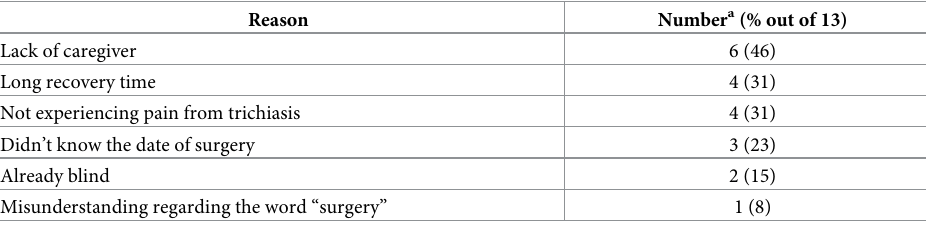
Table 2. Day-of-Surgery reasons for refusal given by trichiasis